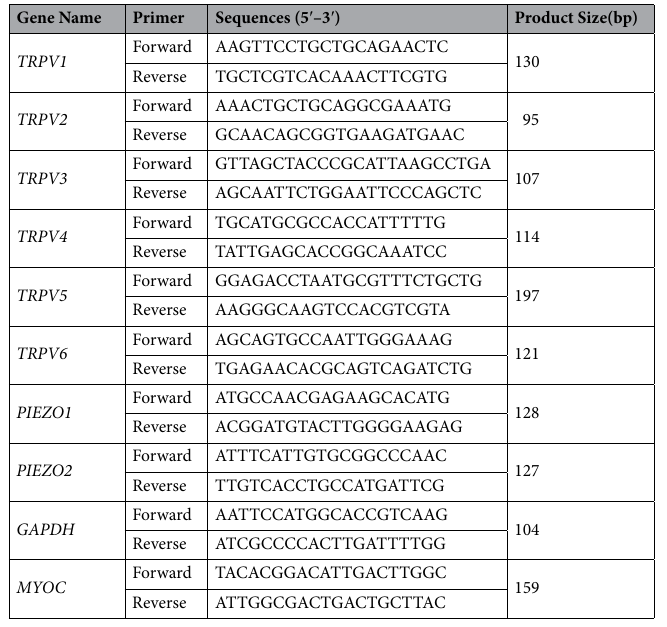
Table 1. Primers specific for TRPV1-6 , PIEZO1-2 , GAPDH , and MYOC